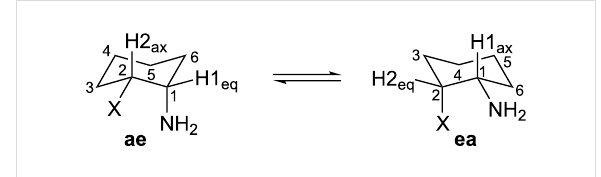
Figure 1: Conformations of cis -2-halocyclohexylamines, where X = F, Cl, Br and